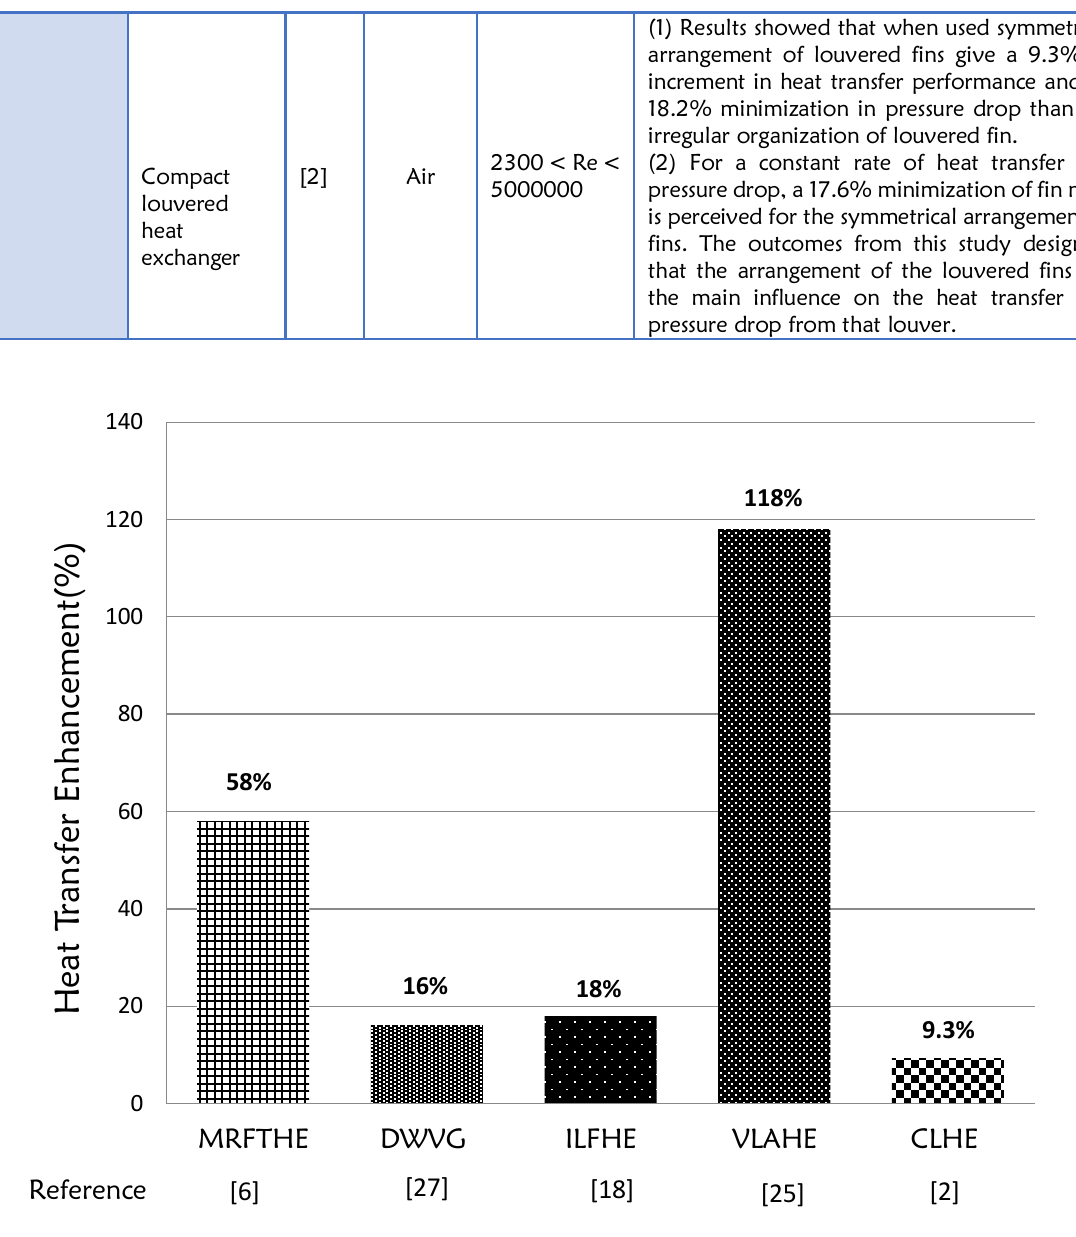
Figure 24: Graphical representation of comparison of heat transfer enhancement of various enhancement